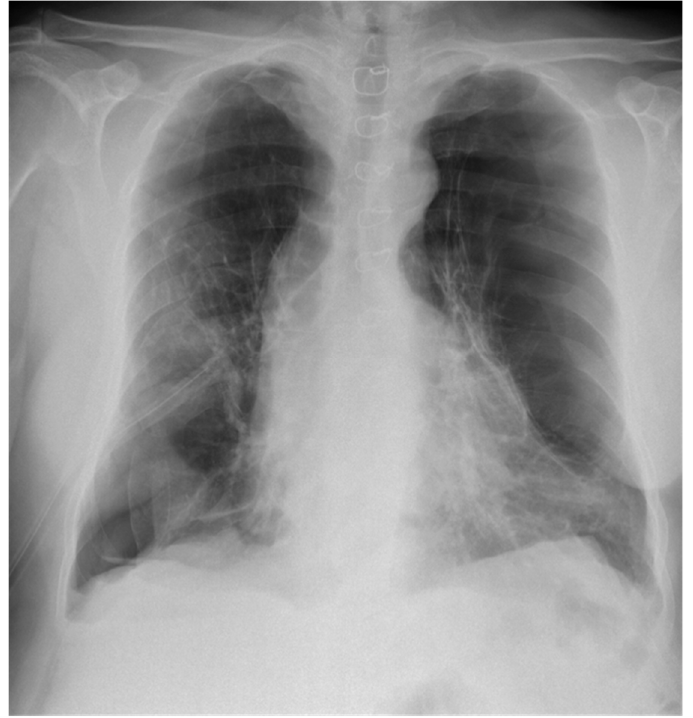
Figure 4. Posteroanterior chest X-ray showing limited expansion of the right lung day 4 after placement of the chest tube.